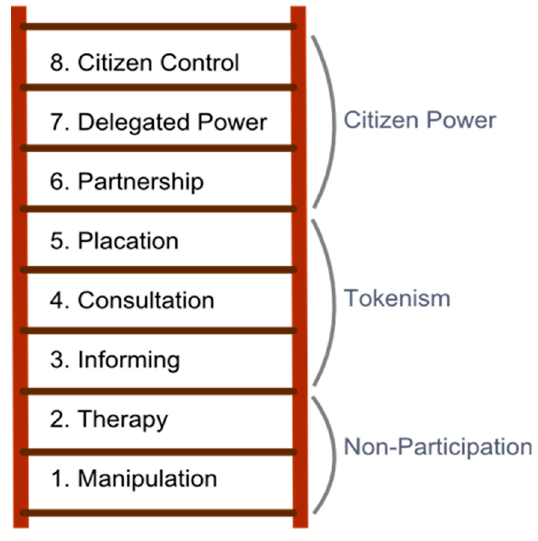
Figure 1. Arnstein’s Ladder of Participation [8].